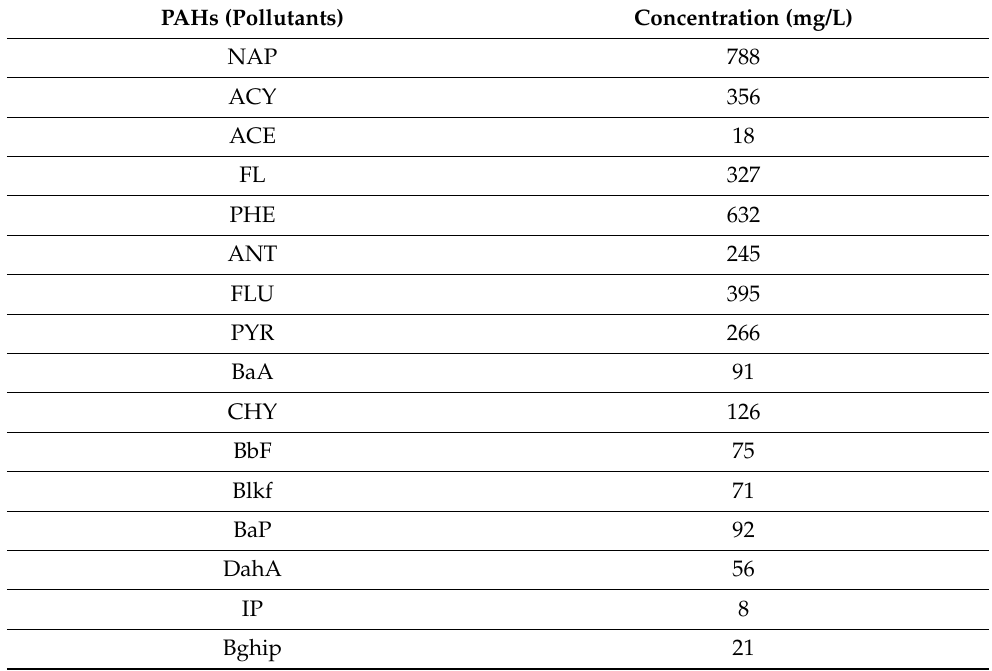
Table 2. PAHs concentration in a coal tar. PAHs